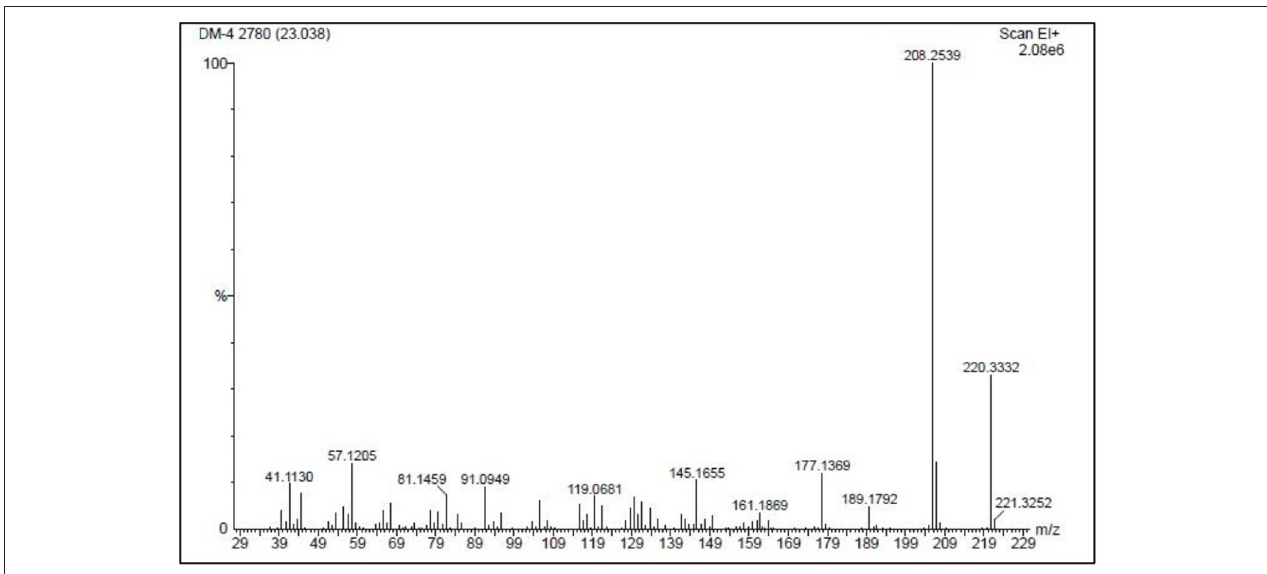
FIGURE 5 | Mass spectrum of compound 1e (r.t. = 23.04min, m/z = 208.25) from an extract of the reaction of 1 with piperidine in 2-MeTHF at 25 ◦